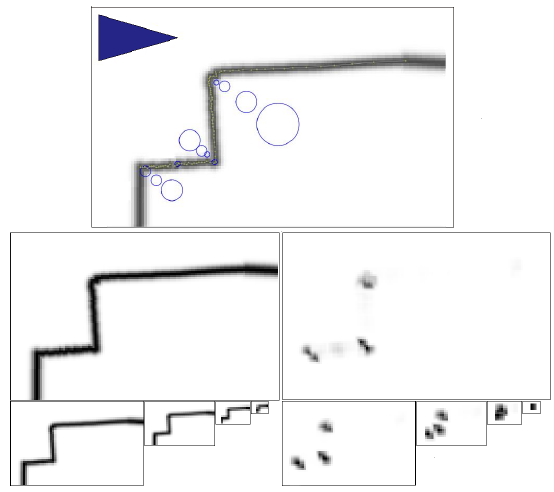
Figure 1. Multi-scale feature extraction from LIDAR data. Our method rasterizes LIDAR data and applies the Kanade-Tomasi corner detector to identify stable and repeatable features. Top: the input image with overlaid local maxima (prior to additional filtering). Circles indicate features, with the radius equal to scale of the feature. Left: image pyramid of input. Right: Corner response pyramid, where local maxima indicate a